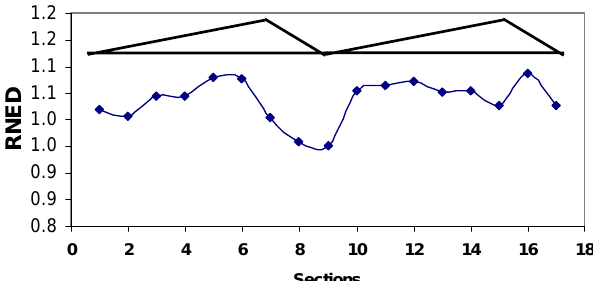
Fig. 10. Ratio of entrained particles to deposited particles (RNED) over Figure 10: Ratio of entrained particles to deposited particles (RNED) over ripples